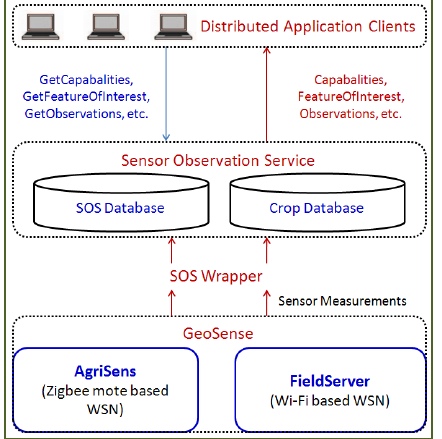
Figure 5. Service Oriented Architecture for GeoSense